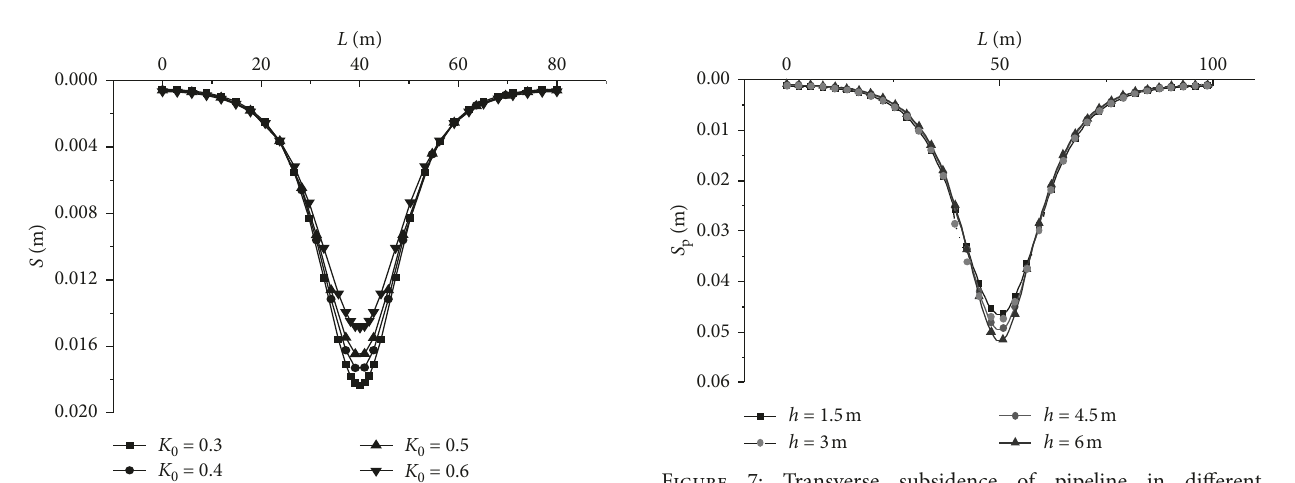
lateral pressure